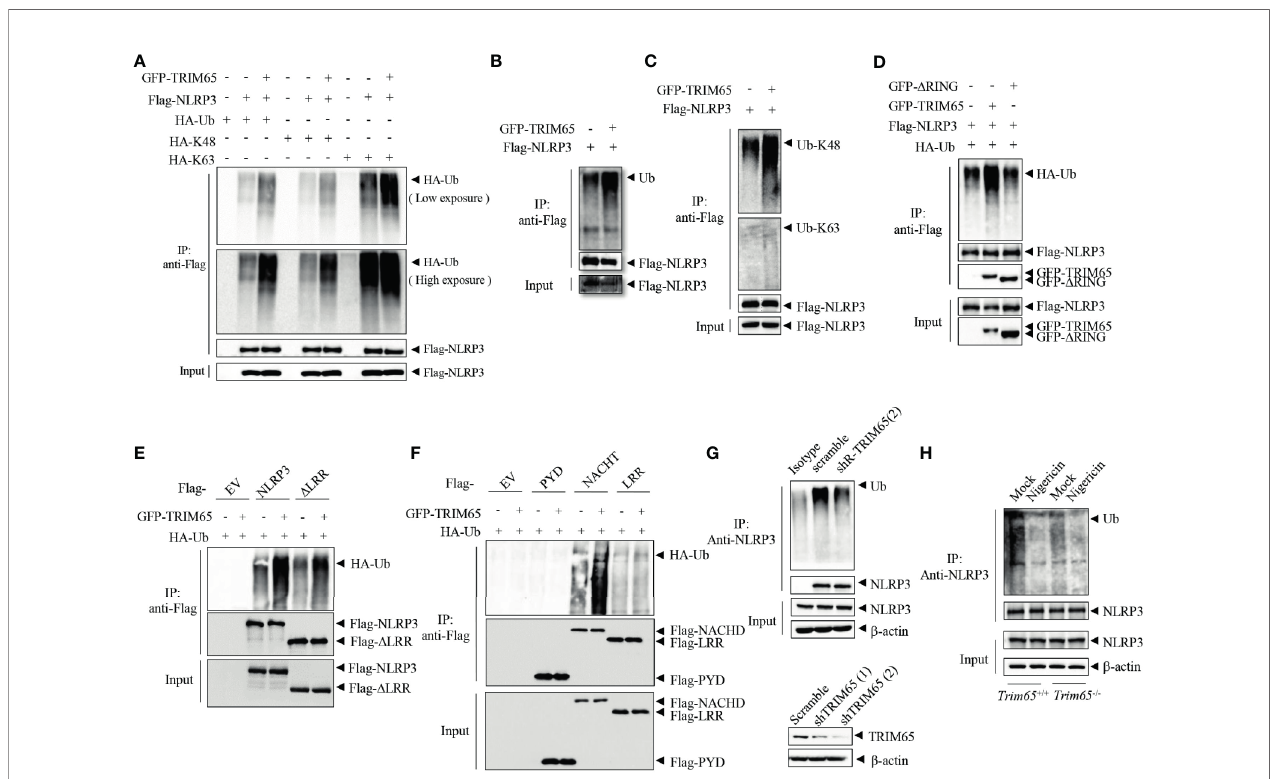
FIGURE 3 | TRIM65 promotes NLRP3 lys48- and lys63- linked ubiquitination. (A) Flag-NLRP3 and GFP-TRIM65 were cotransfected with HA-Ubiquitin, HA-Ubiquitin (K48-linked only), or HA-Ubiquitin (K63-linked only) in HEK-293T cells. The ubiquitination of NLRP3 was analyzed by immunoprecipitation and western blotting. (B, C) Flag-NLRP3 was cotransfected with GFP-TRIM65 in HEK- 293T cells. The overall ubiquitination (B) , K48-linked ubiquitination (C) and K63-linked ubiquitination (C) of NLRP3 were analyzed by immunoprecipitation and western blotting. (D) Flag-NLRP3 was cotransfected with GFP-TRIM65 or GFP-TRIM65 lacking the RING domain in HEK-293T cells. The ubiquitination of NLRP3 was analyzed by immunoprecipitation and western blotting. (E, F) Full-length Flag-NLRP3 and NLRP3 truncation mutants were individually cotransfected with GFP-TRIM65 in HEK-293T cells. Ubiquitination of NLRP3 or its truncation mutants was analyzed by immunoprecipitation and western blotting. (G) Endogenous ubiquitination of NLRP3 in PMA-differentiated and LPS-primed THP-1 cells stably expressing scrambled shRNA or shRNA targeting TRIM65 mRNA was analyzed by immunoprecipitation and western blotting. (H) LPS-primed BMDMs from wild-type or Trim65 -/- mice were stimulated with nigericin, and the endogenous ubiquitination of NLRP3 was analyzed by immunoprecipitation and western blotting. Data are representative of two or three independent experiments. EV, empty